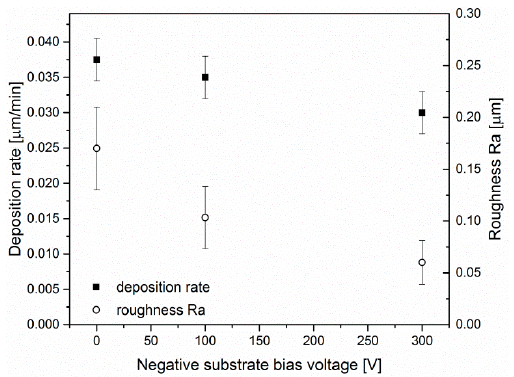
Figure 8. Deposition rate and roughness parameter ( R a ) of AlCrN coatings deposited at substrate temperature of 350 °C and nitrogen pressure 5 Pa at different substrate bias voltages.